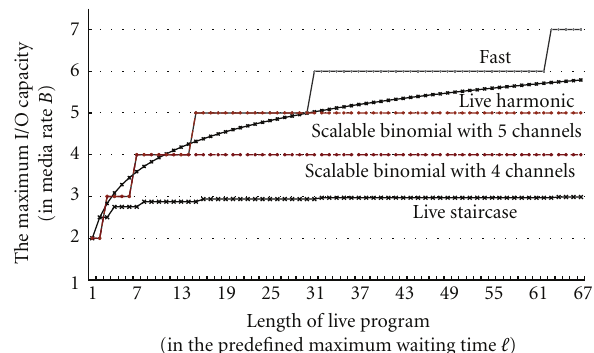
Figure 8: The maximum I/O load on clients versus the length of live videos.